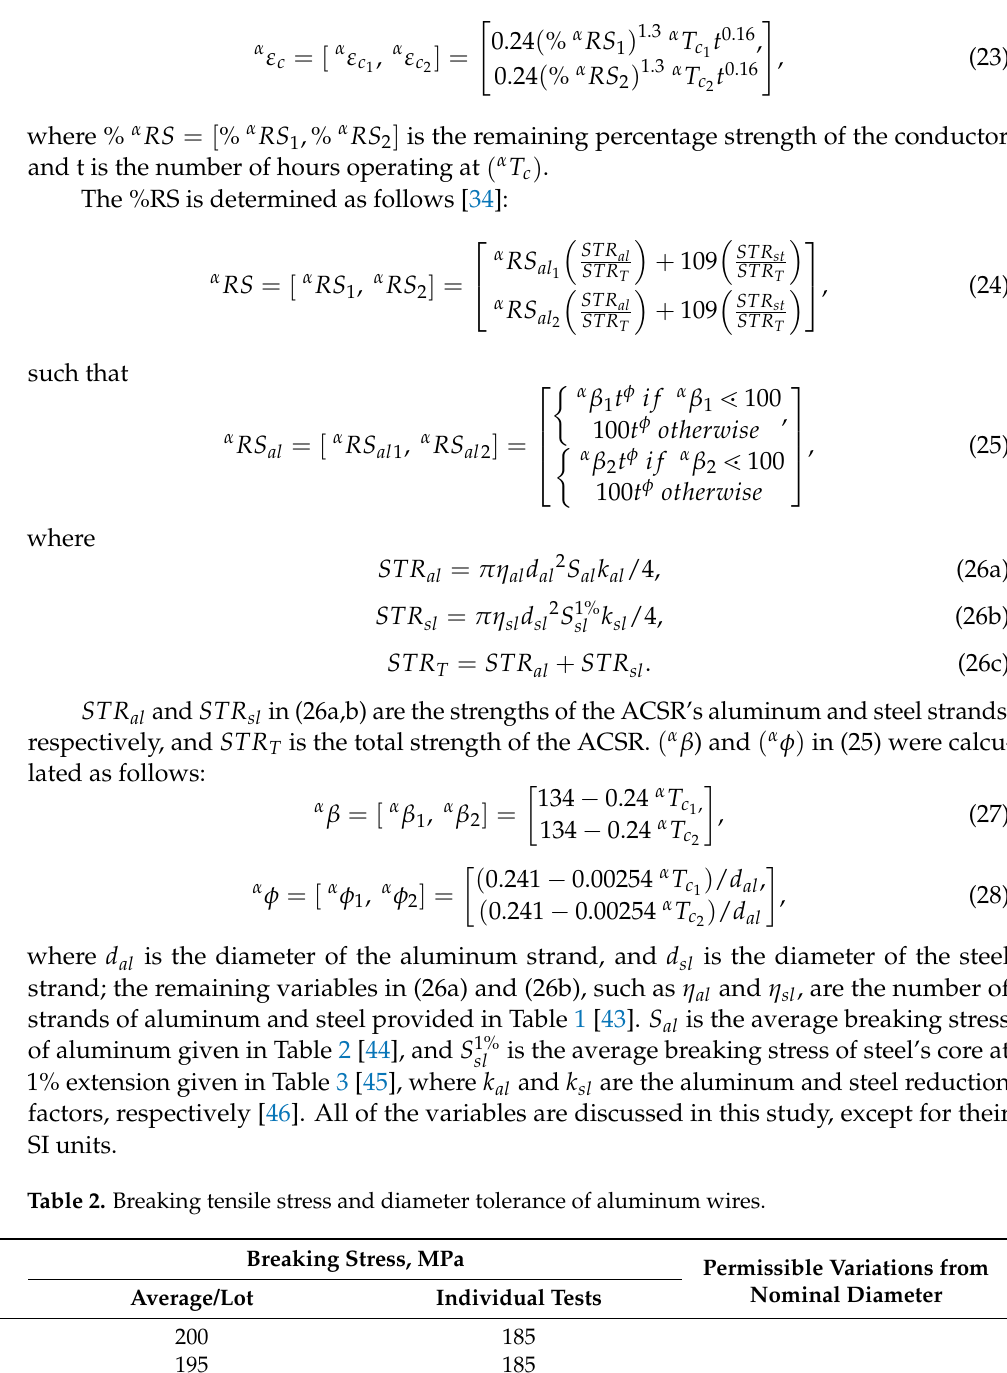
Nominal DiameterAverage/Lot Individual